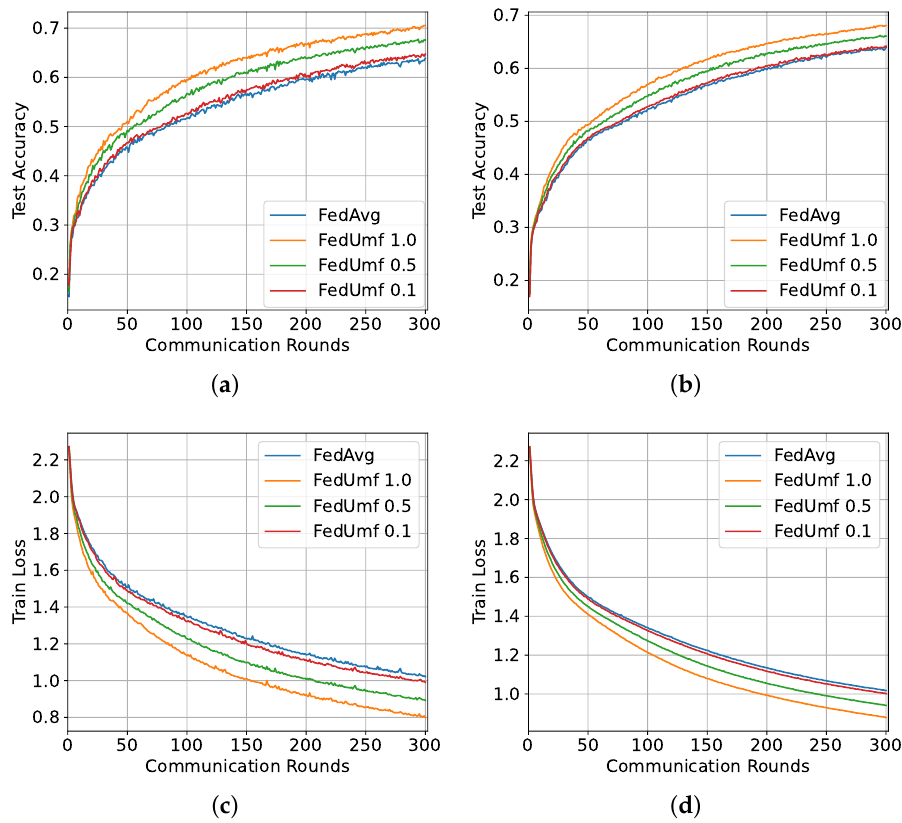
Figure 7. Server test accuracy and client-side training loss curve performance, IID partition and η = 0.01 on CIFAR. ( a ) Test accuracy. C = 0.1. ( b ) Test accuracy. C = 0.5. ( c ) Training loss. C = 0.1. ( d ) Training loss. C =